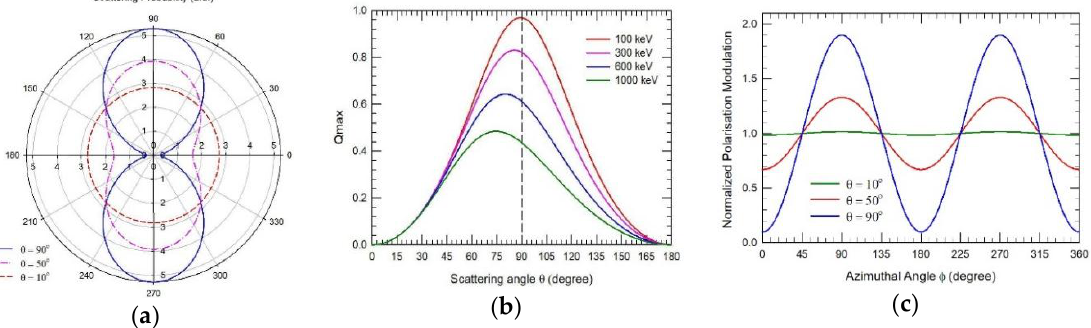
Figure 2. ( a ) The polar plot of the angular distribution in the azimuthal angle for a 200 keV 100% linearly polarized beam undergoing Compton scattering. The shape of this distribution strongly depends on the scattering angle, with a modulation that becomes more and more evident for scattering angles close to 90 degree; ( b ) The modulation curves corresponding to the polar plots in ( a ); for an easier comparison, the modulation curve have been normalized to their respective means; and, ( c ) The maximum modulation expected by 100% polarized photon beam as function of the scattering angle for various energies.